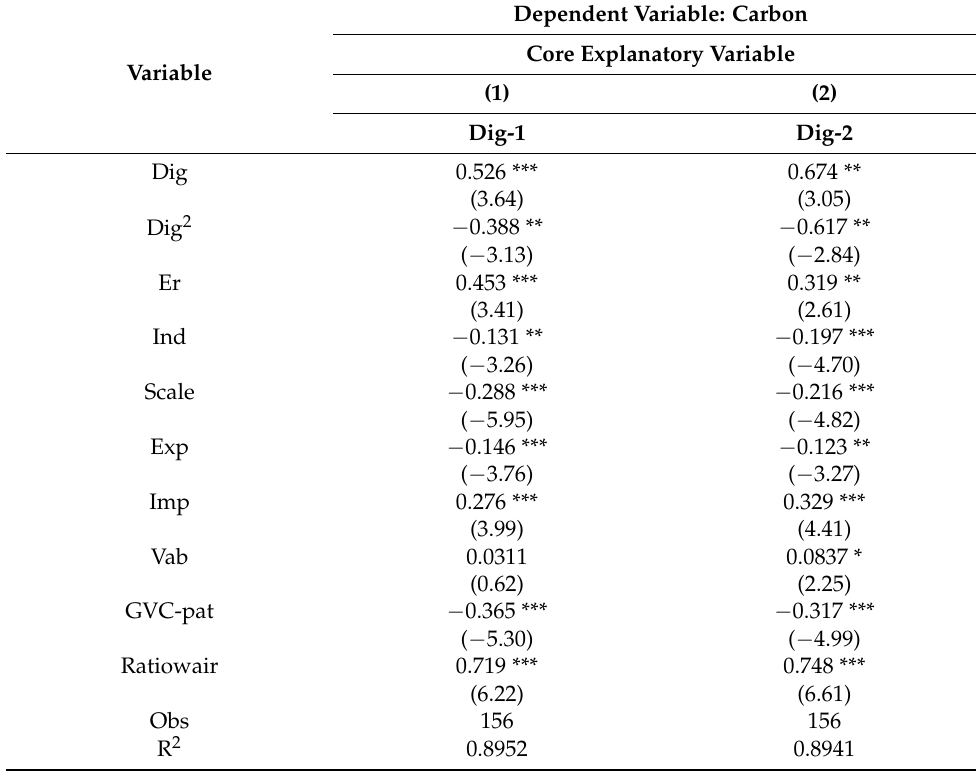
Table 6. Estimation results of IV-2SLS model.